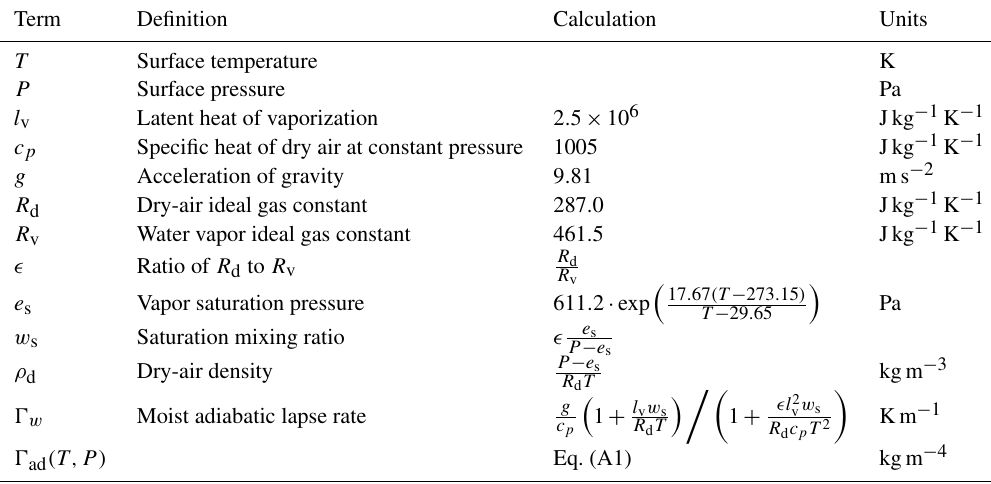
Table A1. List of all the terms needed for the calculation of (cid:48) ad (T,P). Term Definition Calculation